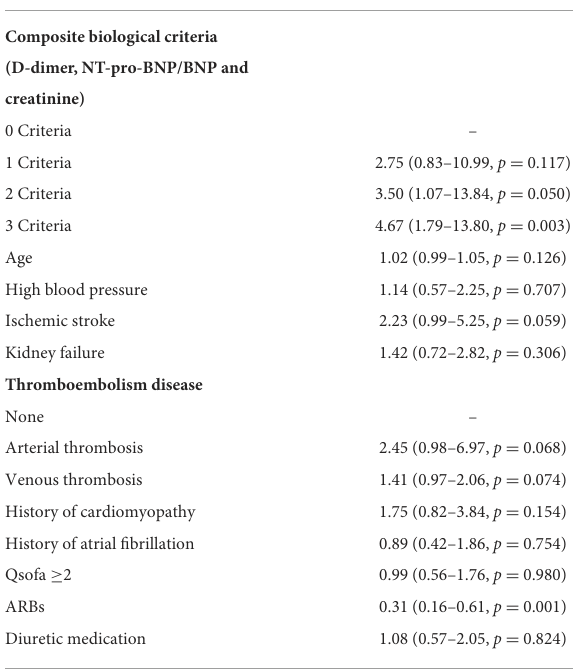
Adjusted OR (95%CI; p